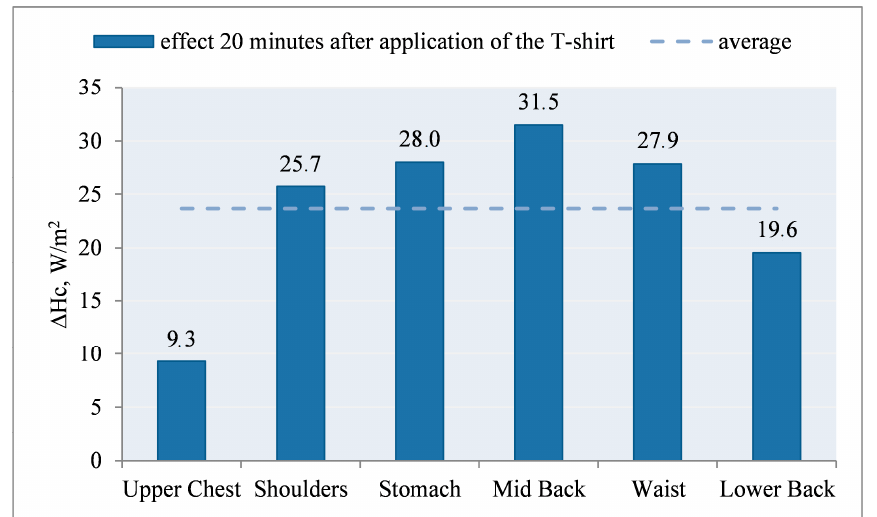
Figure 16. Influence of PCM elements on the thermal manikin: difference in the density of heat fluxes ∆ Hci_cool 20 min after application of T-shirt A under the outer clothing on the selected manikin segments for the values obtained for variant IV and